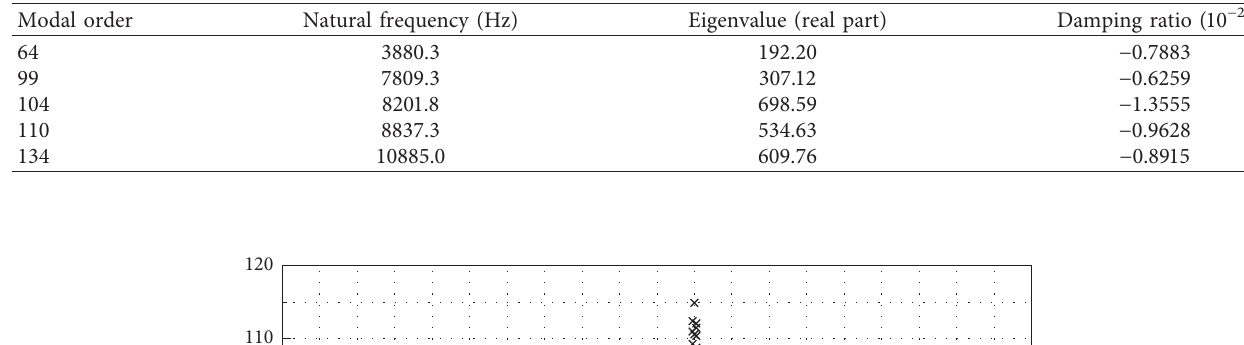
Figure 2: Bracket and disk boundary conditions. Table 3: Noisy modes in the finite element analysis.